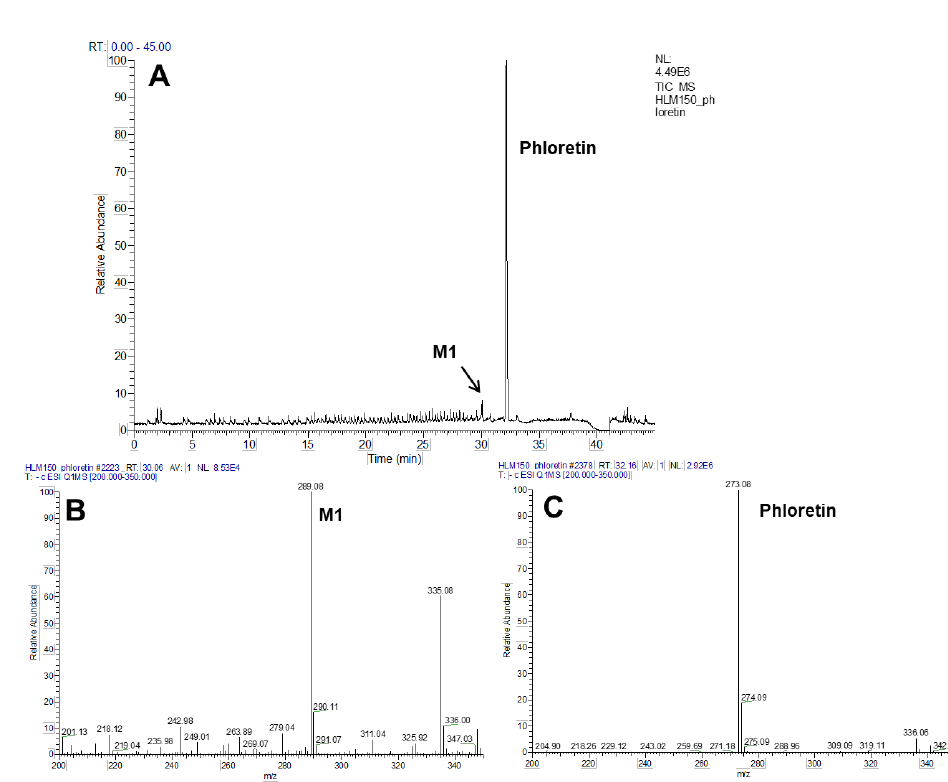
Figure 3. LC-MS analyses of the phloretin metabolite via human liver microsomes (HLMs). LC-MS chromatogram of phloretin metabolites catalyzed by HLMs in the presence ( A ) of NADPH. The MS spectra show that the protonated molecular ions of 3-OH phloretin ( B ) and phloretin ( C ) were 289 and 273, respectively.